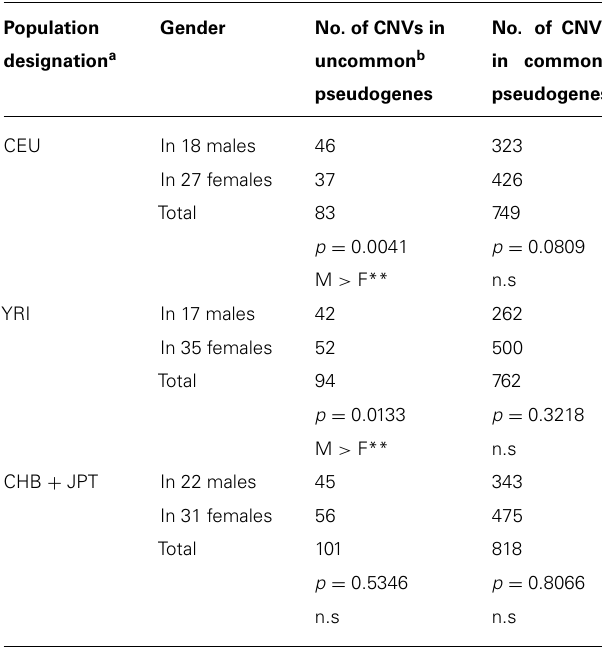
Table 2 | Gender comparisons of the CNV numbers among OR genes and pseudogenes in three diverse populations. Population